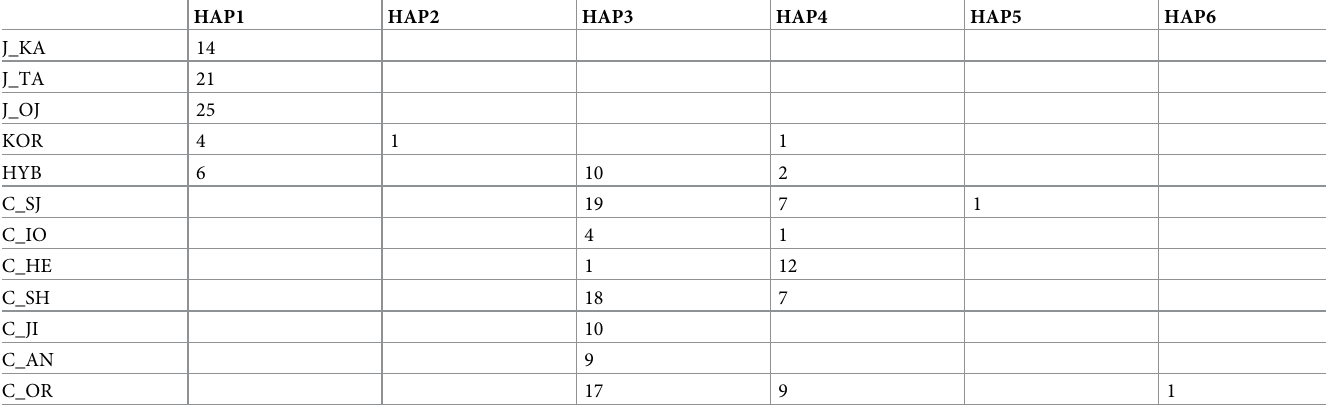
sponding to their respective species. On the other hand, most Japanese–Chinese hybrid culti- vars (HYB) had admixed structure, i.e., had approximately equal membership in both the “red” and “light green” clusters. Among the HYB cultivars, only ‘Ikaba’ (ID#67) had member- ship predominantly in the “light green” (Chinese) cluster. In both the Japanese and Chinese chestnut cultivar groups, a few cultivars had admixed structures (ratio of red:light green = 0.78:0.22 for ‘Obiwase’, 0.24:0.76 for ‘Hamjung 3’, and 0.16:0.84; for ‘Miyagawa 18’). Some Chinese chestnut cultivars had very low membership in the “red” (Japanese) cluster, but the amount was too small to declare that they were hybrids (for example, red:light green = 0.04:0.96 for ‘Tokuganri A’ and 0.03:0.97 for ‘2399’). Table 3. Haplotype frequencies in the set of 200 cultivars. HAP1 HAP2